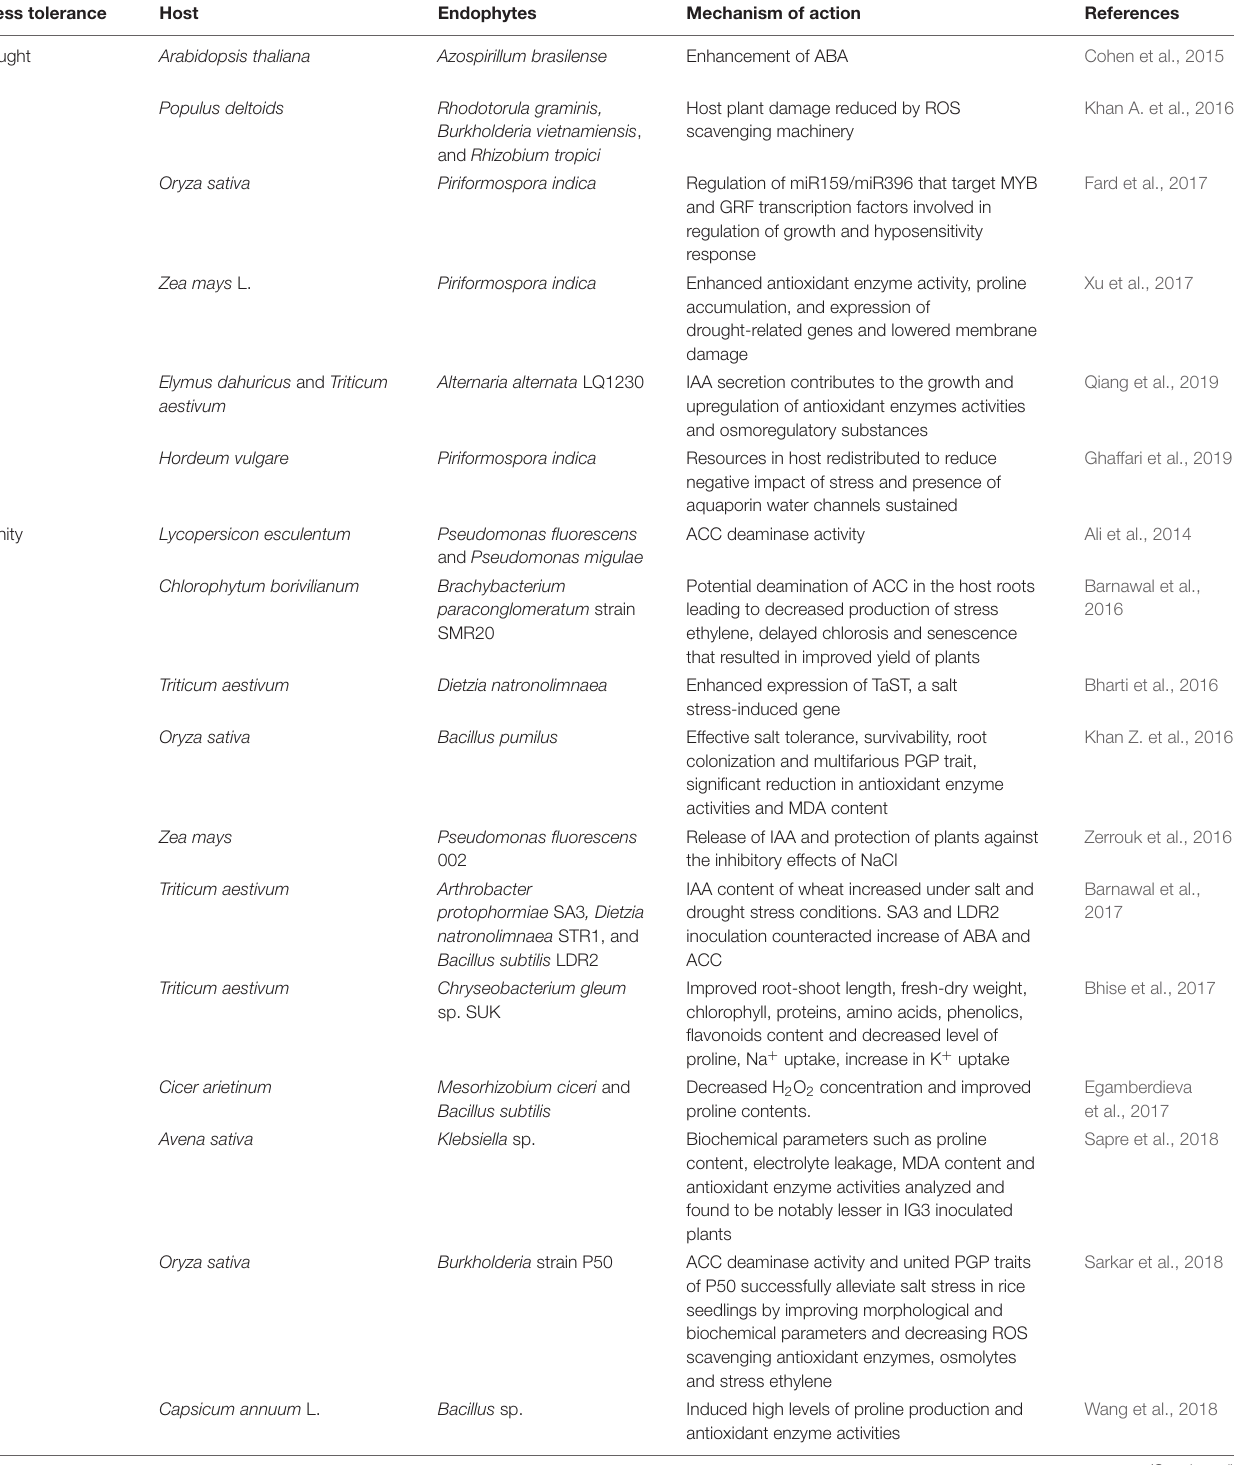
TABLE 3 | Endophytes inducing abiotic stress tolerance in host